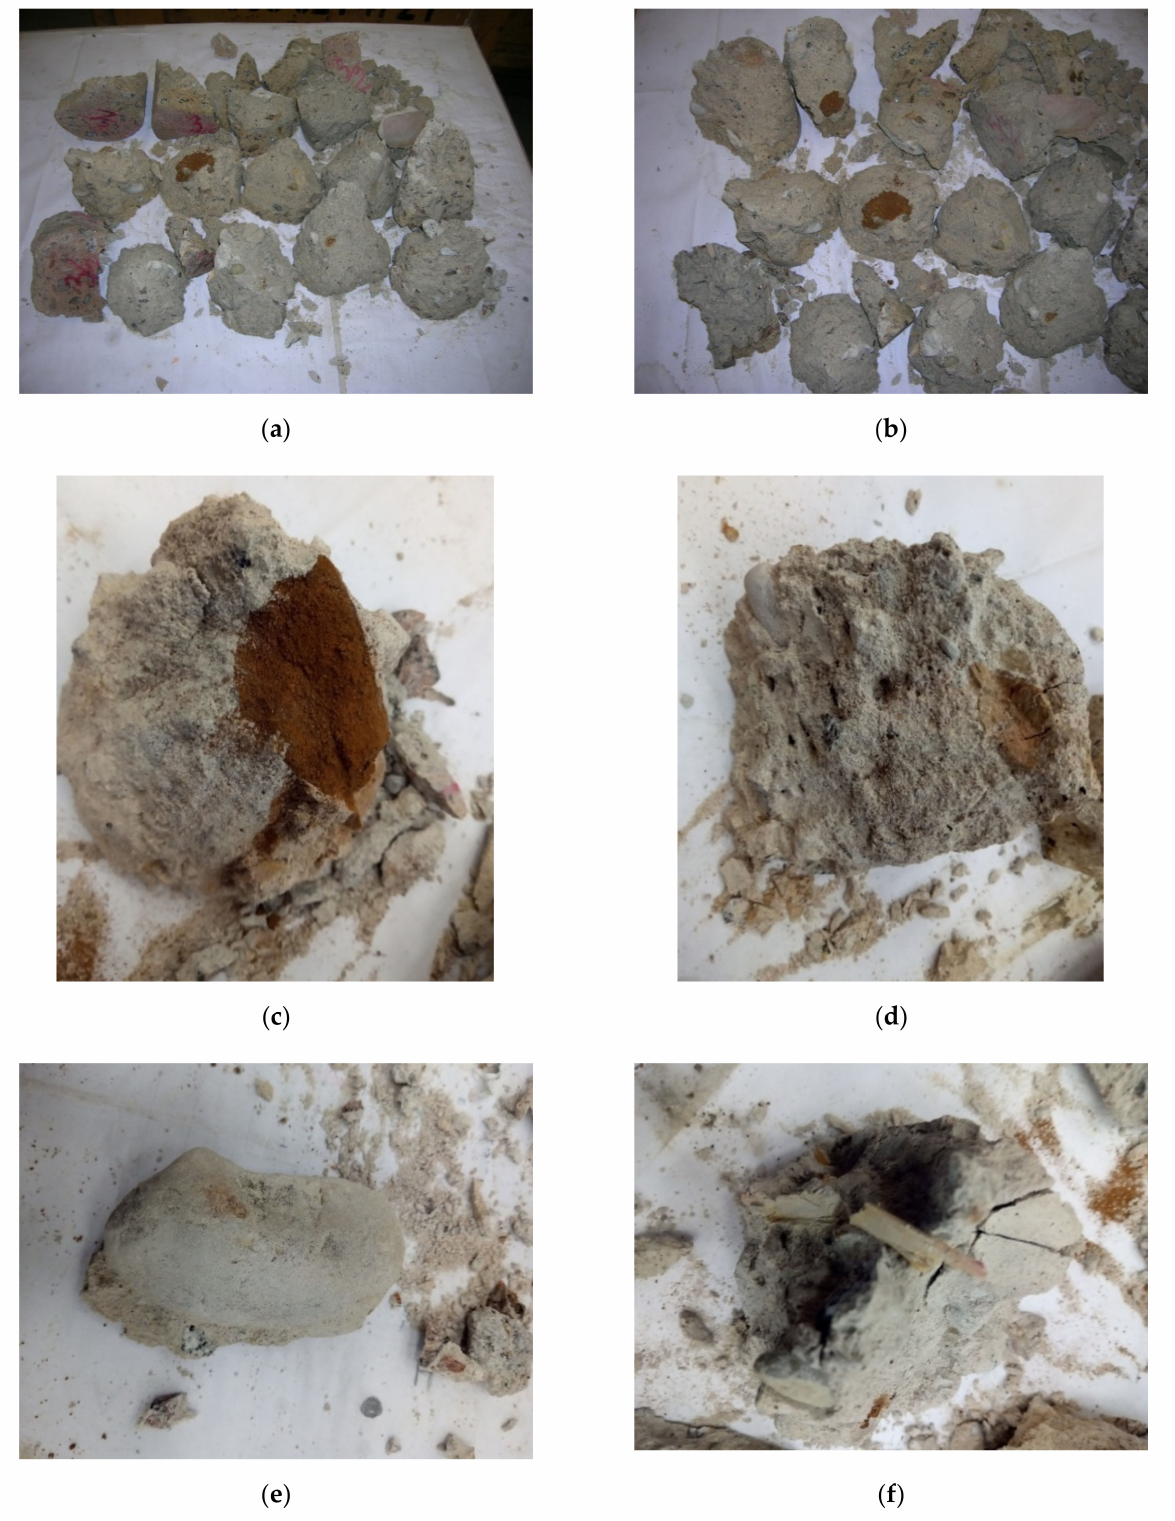
Figure 6. Concrete specimens after uniaxial compressive tests: ( a , b ) Form of specimens failure; ( c ) dirty fine aggregate; ( d ) clay inclusion; ( e ) large stone; ( f ) timber